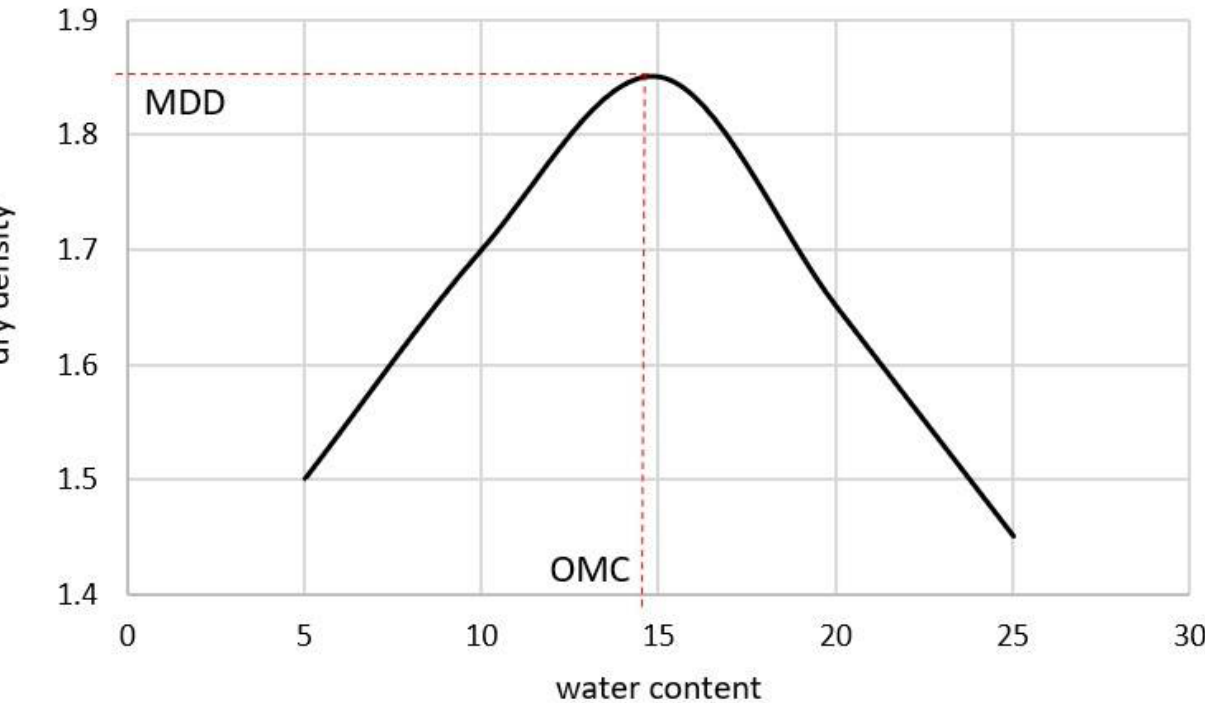
Figure 1. OMC, MDD general curve